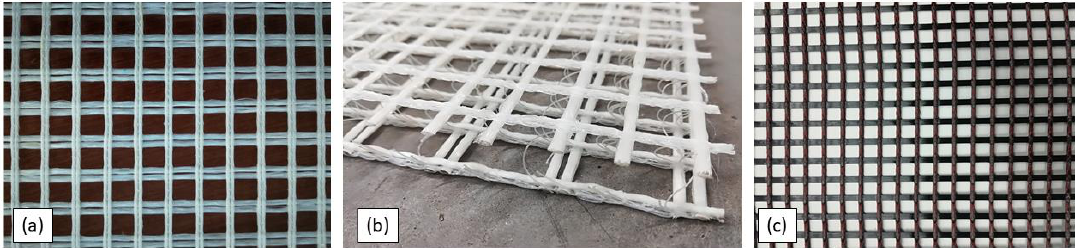
Figure 1. ( a ) 2D styrene-butadiene ( SBR) coated glass-fiber textile; ( b ) 3D SBR coated glass-fiber textile; ( c ) SBR coated carbon-fiber textile.